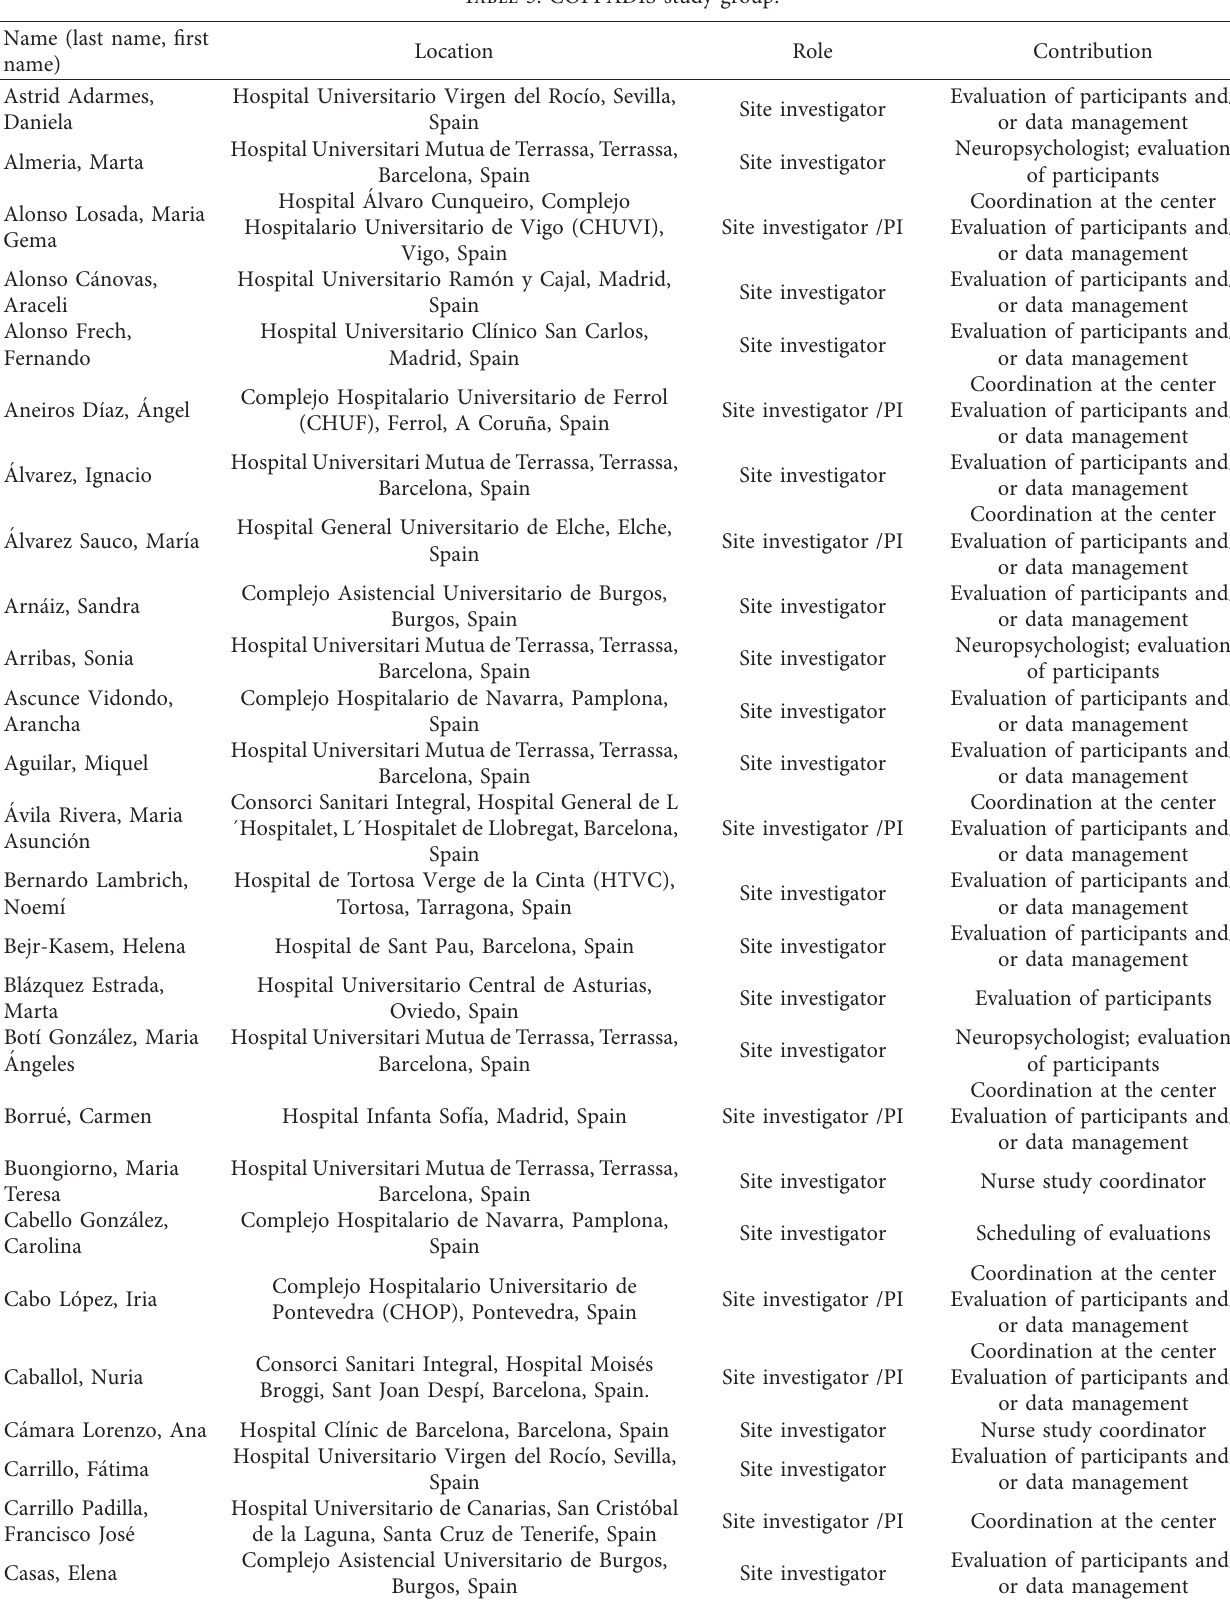
Table 5: COPPADIS study